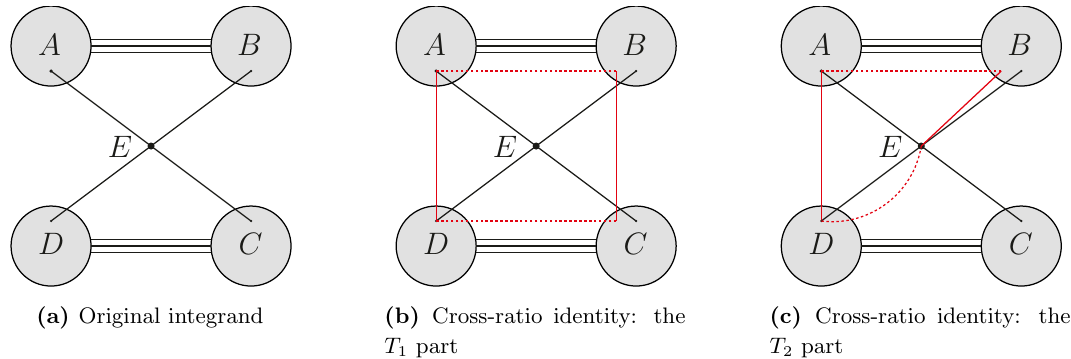
Figure 4. Con(cid:12)guration of the original integrand and the cross-ratio identity of the rule III. The red lines represent terms z jd z ia and z ed z ia provided by the cross-ratio z ij z ad z ie z ad